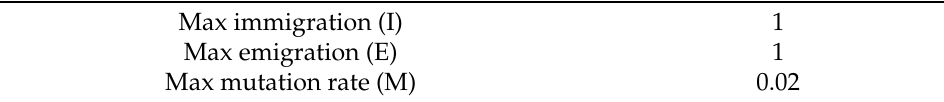
Table 3. Employed parameters setting for BBO.